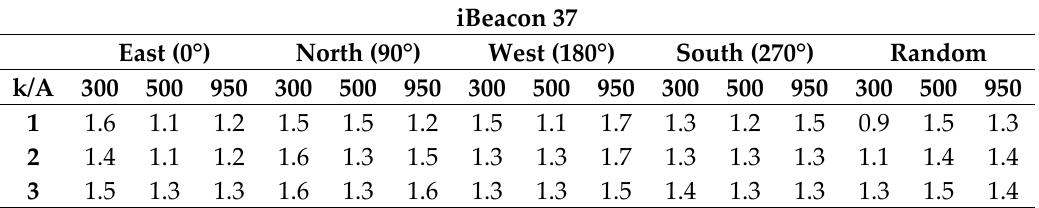
Table 1. Accuracy (m) for iBeacon protocol, channel 37 and Euclidean distance.